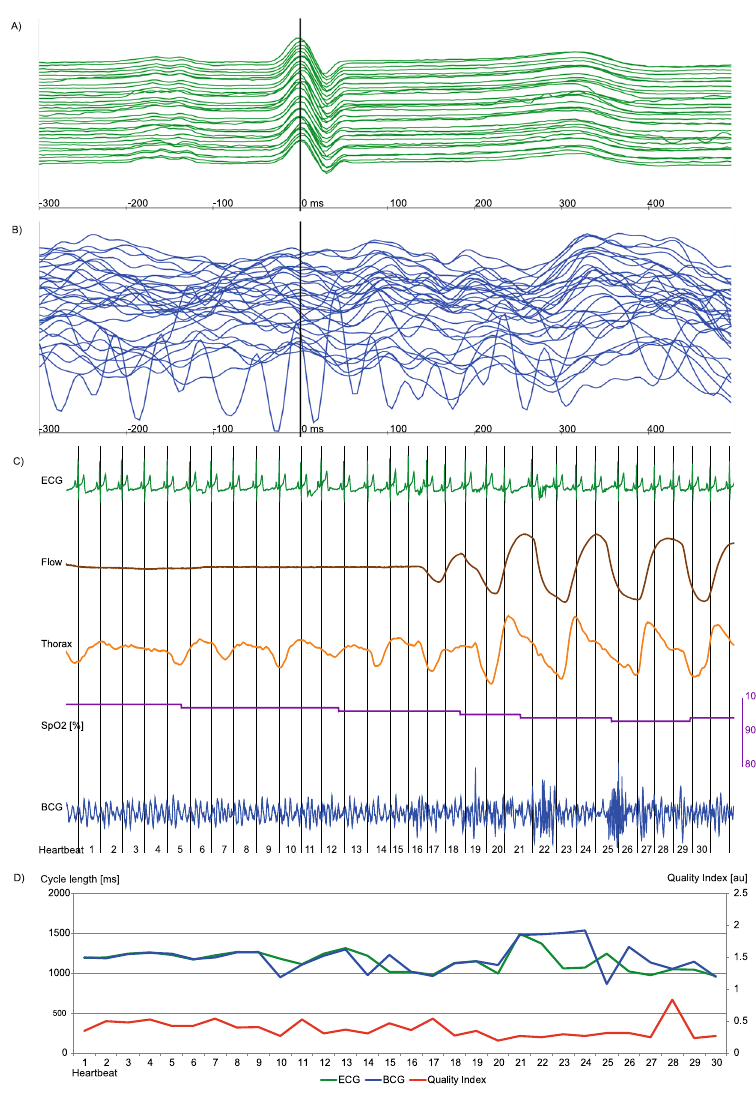
Figure 5. Episode of obstructive sleeping apnea with acceptable signal correlation. While the estimator calculates a good BCG to ECG correlation during the apnea phase, the phase of arousal is associated with increased muscular tone leading to a BCG to ECG mismatch and a decreased QI (Fig. 5D). Each signal is visualized by a unique colour: ECG (green), BCG (blue), Airflow (brown), thorax movement (orange), oxygen saturation (purple) and QI (red). ( A , B ) Plot of 32 consecutive heartbeats. The upper-most signal is the start, the bottom-most is the end of the sequence. The signals are synchronized and the maximum of R peak in ECG signal is situated at 0 ms. While the ECG is virtually not affected by the increased muscular tone of the phase of arousal, the BCG analysis is hampered by a strong superposition of mechanic heart activity. A: P-waves can be identified. In the lower third of the plot the ECG signal is slightly affected by increased body movement. B: The BCG signal suffers from strong deterioration due to body movement during this episode of obstructive sleeping apnea. At the upper half, a specific BCG sequence can be identified whereas at the lower half the identification of a decent amplitude sequence becomes more difficult. ( C ) Plot with simultaneously recorded ECG, air flow (brown), thoracic movement (orange, oxygen saturation (purple) and BCG (blue) deflection. There is nearly no flow due to the obstruction of the upper airway indicated by a near flatline in the flow signal. With decreasing oxygen saturation, thoracic movement increases and leads to an arousal-correlated reaction with increased muscular tone and superposition of mechanic heart activity. ( D ) A continuous BCG measurement is feasible but signal analysis is hampered during arousal and lacks good signal correlation in heartbeats 10, 14, 15, 20–29, indicated by a low QI. As soon as the muscular tone decreases, the algorithm again offers good BCG signal analysis indicated by a good QI in heartbeat